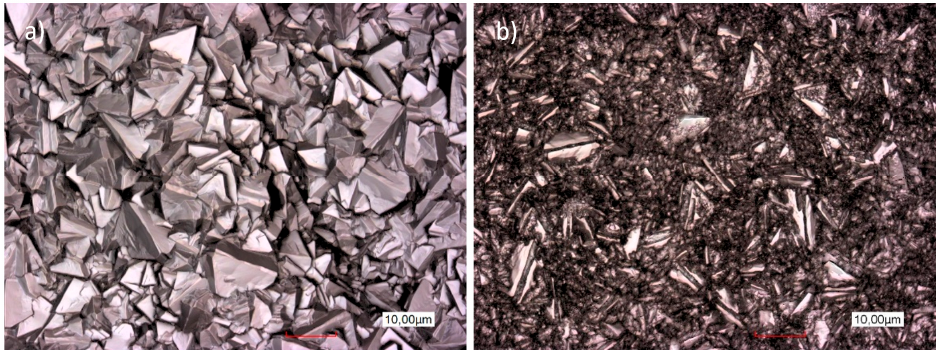
Figure 3. Laser scanning microscope photographs of the Ta-based boron-doped diamond anode ( a ) before initial operation and ( b ) after 12,222 h of operation. The test conditions during treatment lead to corrosive reactions to the BDD surface due